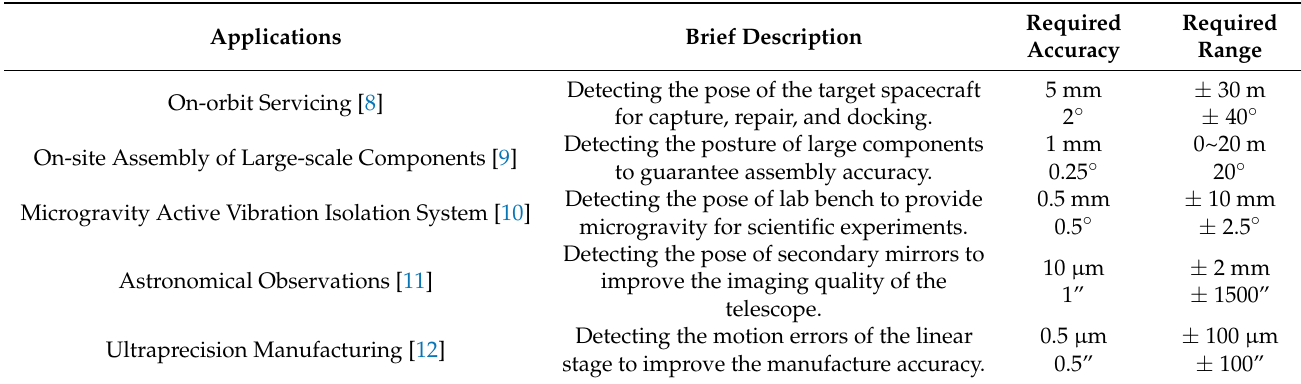
Required Required Accuracy Range